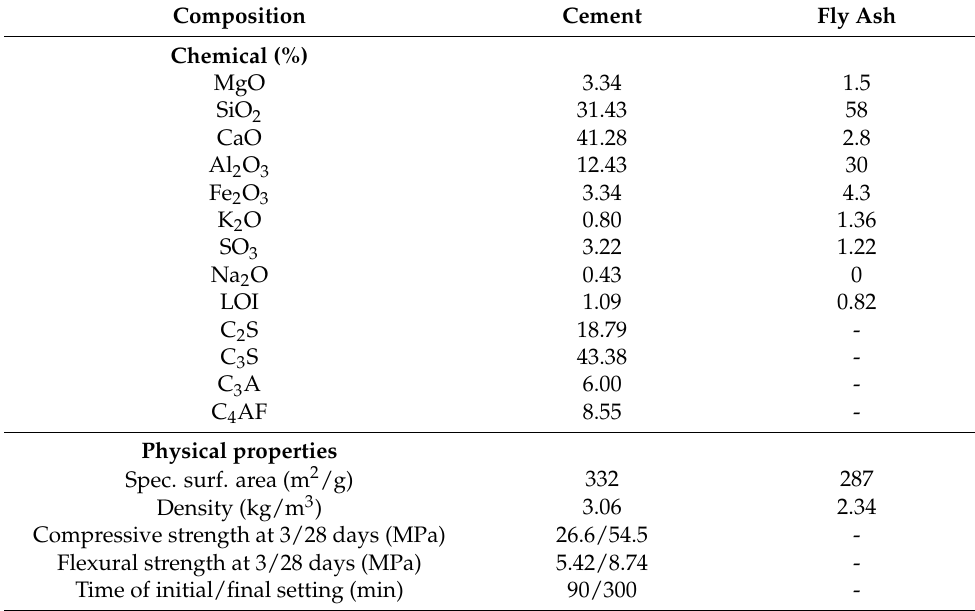
Table 1. Chemical composition and physical properties of cement and fly ash (%).